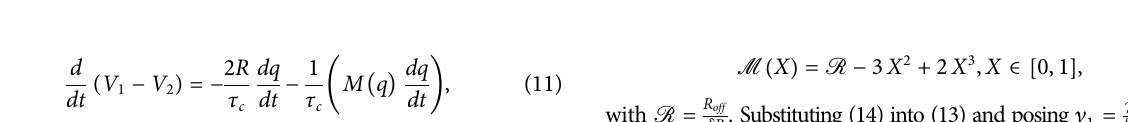
(cid:1) 46 μ C and q (cid:1) 31 μ C with V (cid:1) 1 V , V (cid:1) 0 V for Cond-1 (solid curves) and V 0 2 1 0 2 0 1